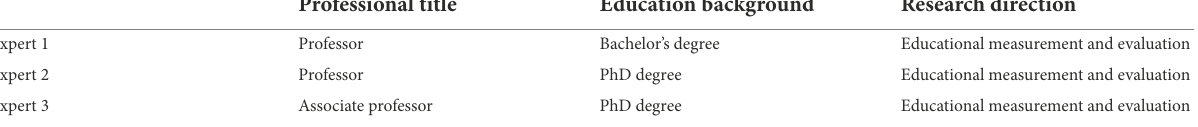
TABLE 1 Expert panel member